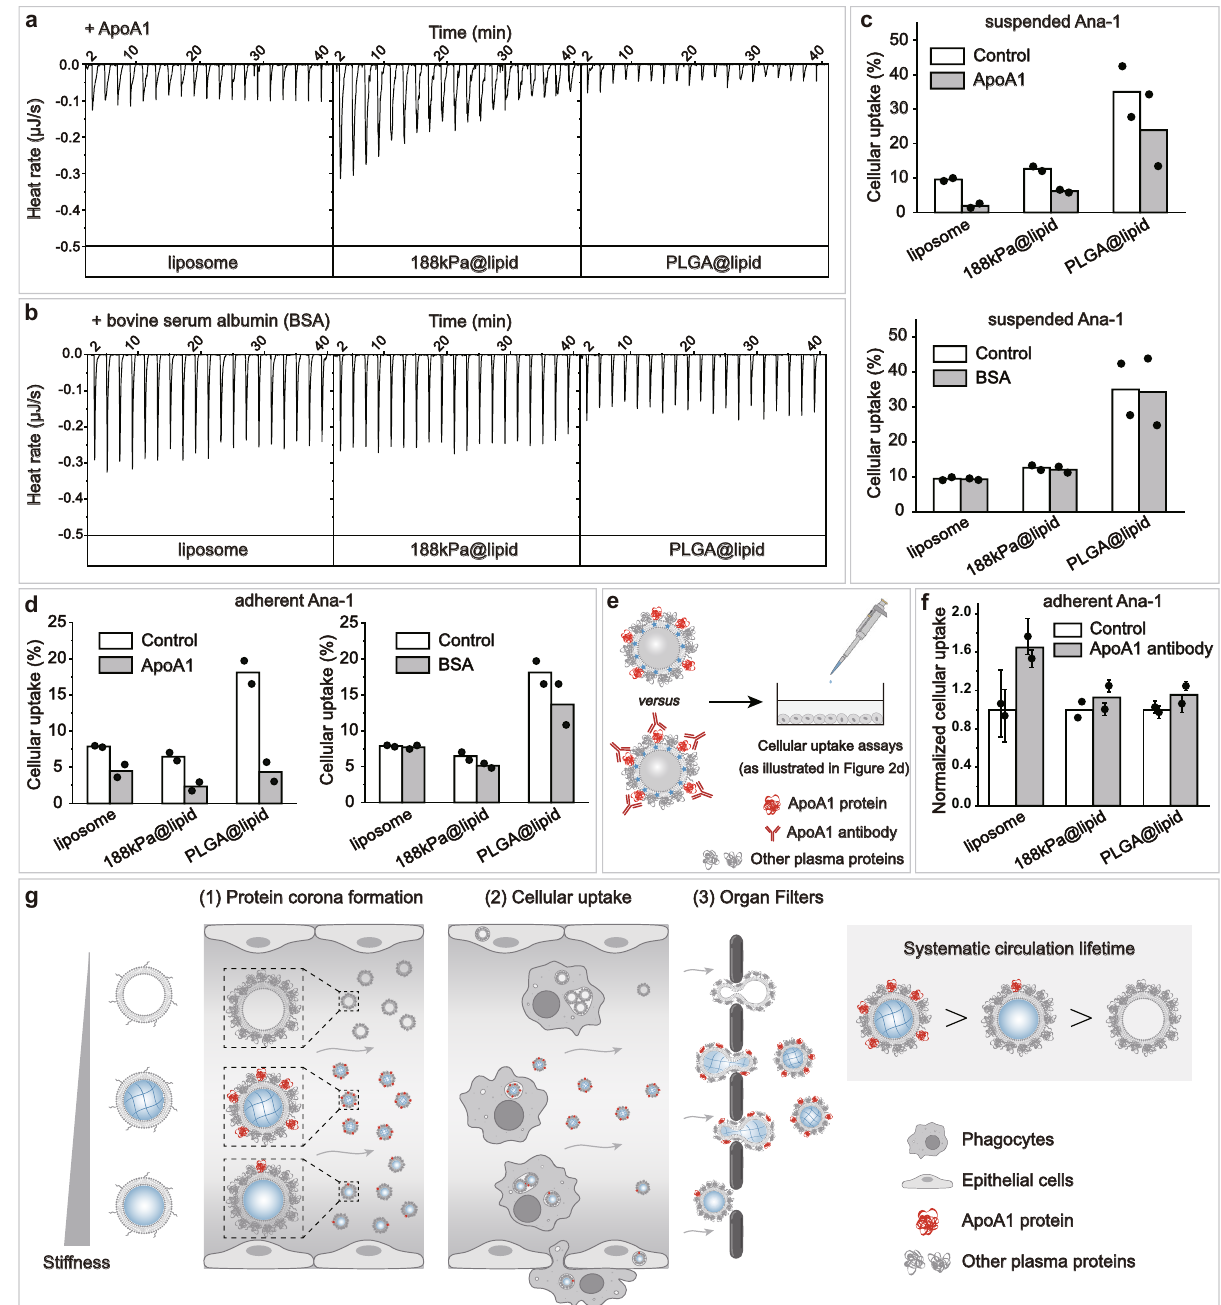
Fig. 4 Roles of Apolipoprotein A-I (ApoA1) in nanoparticle elasticity-dependence of systemic circulation lifetime. Raw data from isothermal titration calorimetry (ITC) assays, in which a ApoA1 and b bovine serum albumin (BSA) solution was titrated into nanoparticle dispersions, using liposome, 188 kPa@lipid, and PLGA@lipid as representatives for nanoparticles with distinct elasticity. c Effects of the presence of ApoA1 and BSA (both at 50 μ g/mL) on the uptake ef fi ciency of our representative nanoparticles by suspended Ana-1 cells in RPMI-1640. Bar height are reported as average of two independent trials. d Effects of the presence of ApoA1 and BSA (both at 50 μ g/mL) on the uptake ef fi ciency of our representative nanoparticles by adherent Ana-1 cells in DMEM. Bar height are reported as average of two independent trials. e Schematic illustration on cellular uptake assays for examining the effects pre- screening/pre-shielding the adsorbed ApoA1 in corona with ApoA1 antibody. f Cellular uptake of a nanoparticle with and without ApoA1 in corona